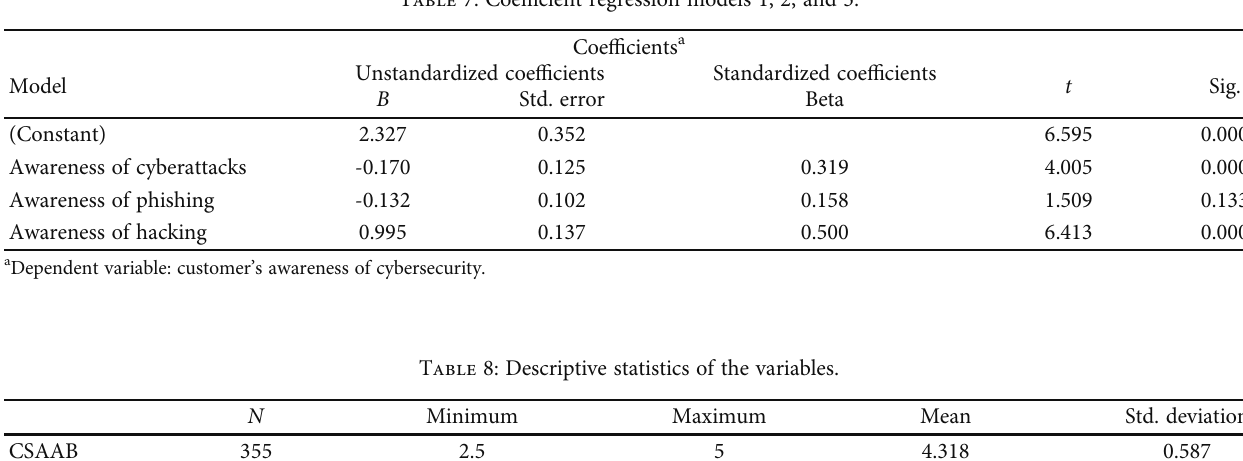
Table 7: Coe ffi cient regression models 1, 2, and 3.